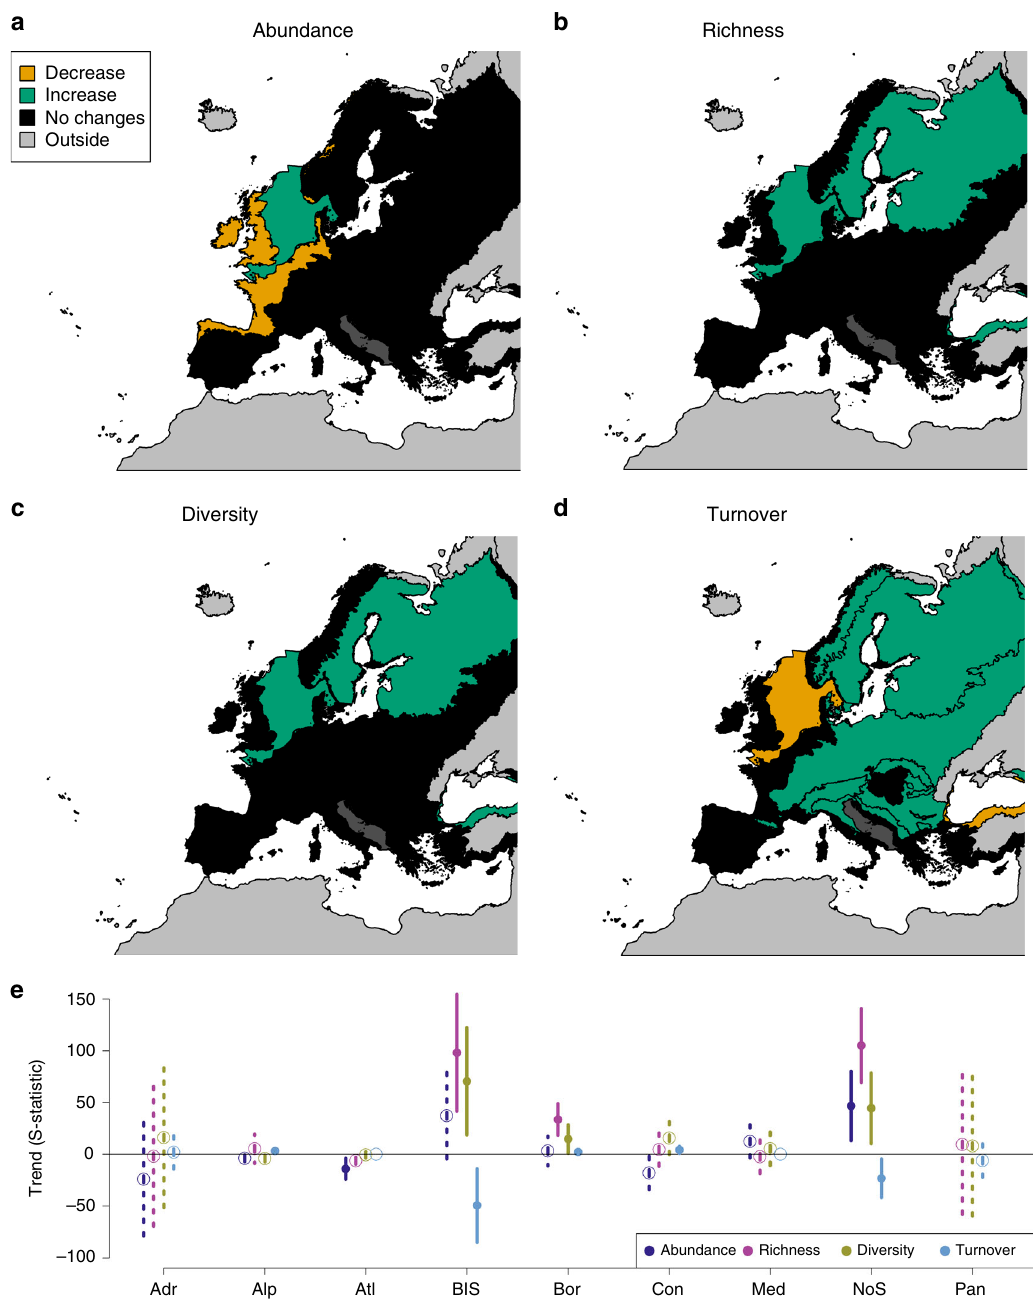
Fig. 2 Biodiversity trends in the different biogeoregions. The results of meta-analysis mixed models are shown for the four studied biodiversity metrics: abundance ( a ), richness ( b ), diversity ( c ) and turnover ( d ). Green: signi fi cant increasing trends ( p ≤ 0.05); orange: signi fi cantly declining trends ( p ≤ 0.05); black (dark grey for Adriatic Sea): no signi fi cant trends ( p > 0.05). For biogeoregion identity see Fig. 1. e Values of S-statistics (model estimated mean, error bar: + / − C.I.). Adr: Adriatic ( n = 1 time series), Alp: Alpine ( n = 33 time series), Atl Atlantic ( n = 56 time series), BlS Black Sea ( n = 5 time series), Bor Boreal ( n = 32 time series), Con Continental ( n = 17 time series), Med Mediterranean ( n = 9 time series), NoS North Sea ( n = 7 time series), and Pan Pannonian ( n = 1 time series). Dark blue: abundance, pink: richness, yellow: diversity, light blue: turnover. Solid line and dot: p ≤ 0.05; dashed line and open circle: p > 0.05. Source data are provided as a Source Data fi